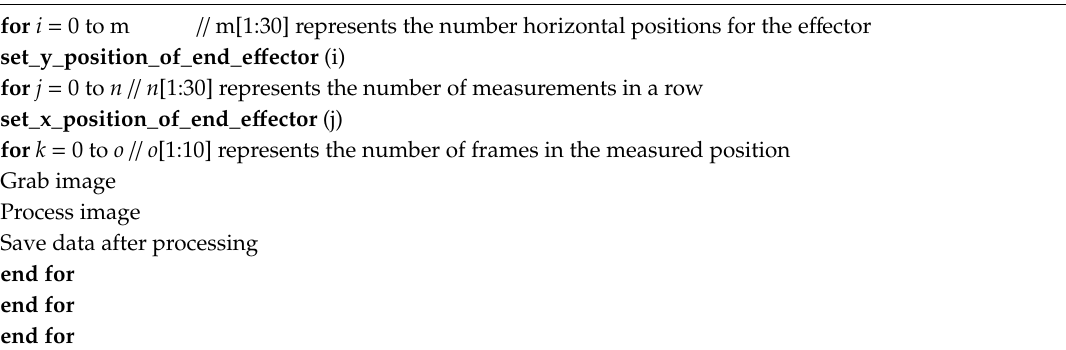
Algorithm 1. The Measurement